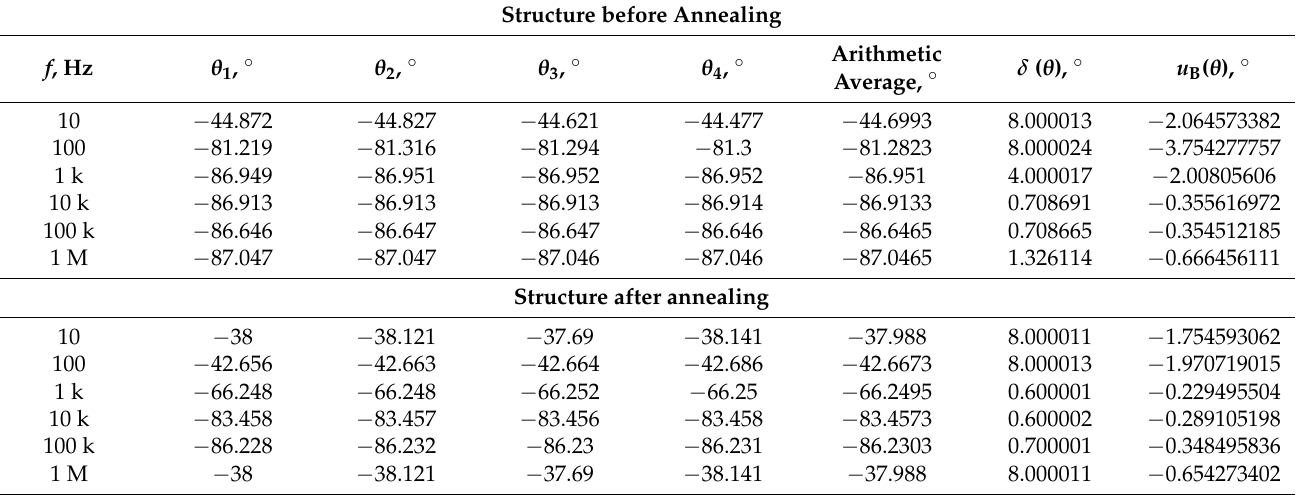
Table 3. List of parameters necessary to determine the standard measurement uncertainty of type B for measurements of phase shift angle θ